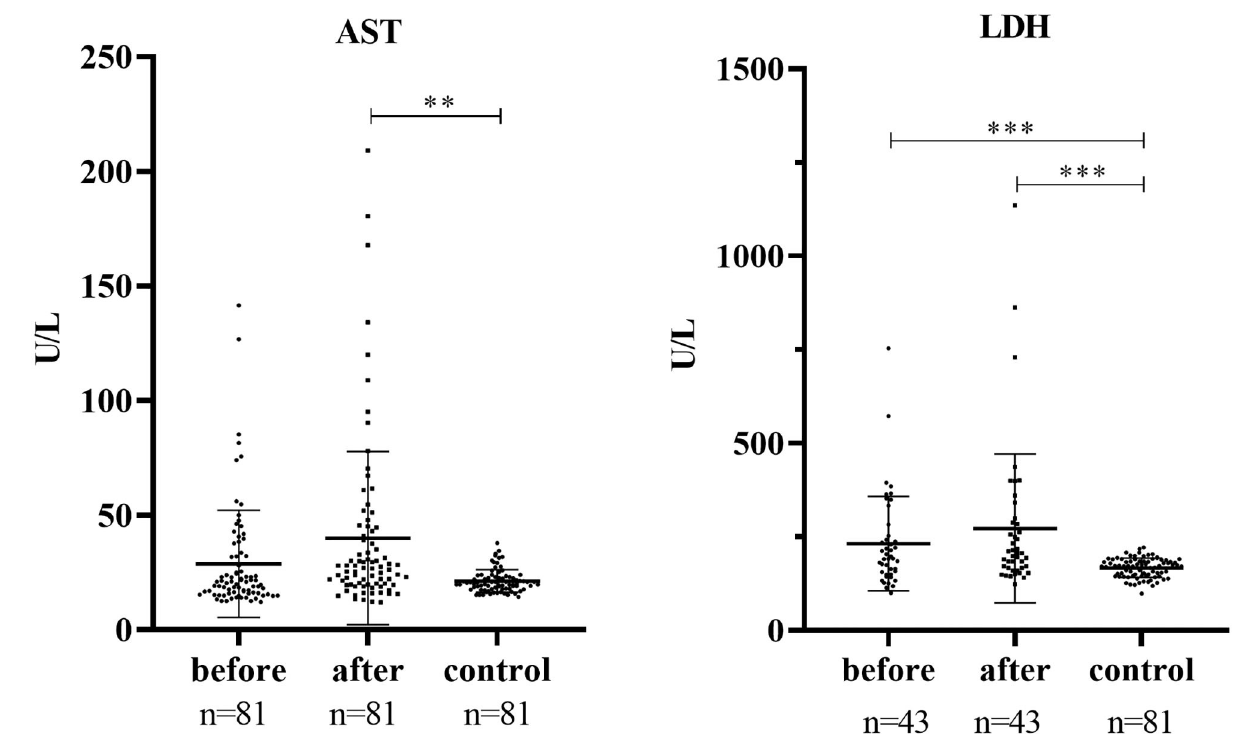
FIGURE 1 | Serum AST and LDH activities in patients and health control. *** P < 0.001, ** P <